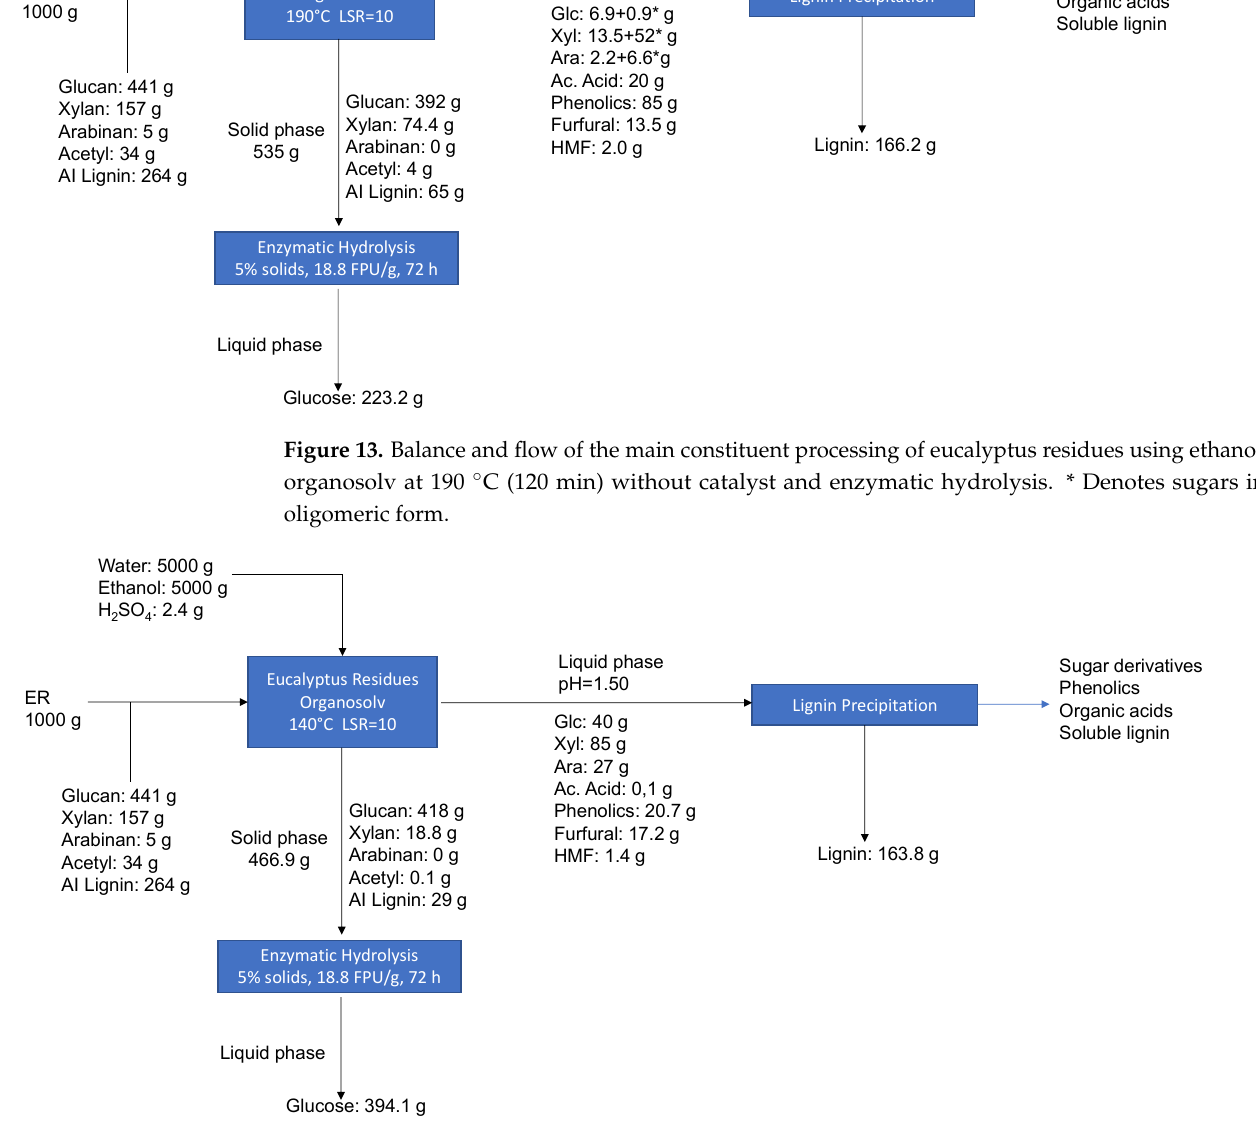
Figure 14. Balance and flow of the main constituent processing of eucalyptus residues using ethanol organosolv at 140 ◦ C (120 min) catalysed with sulphuric acid and enzymatic hydrolysis. Organosolv pre-treatments produced cellulose (glucan)-enriched pulps that, after saccharification with enzymes, provided a glucose-rich stream that can be easily converted into advanced biofuels. Under non-catalysed conditions, glucan (and also potential glucose) amounts were higher for the ERs than for the WS (Figures 12 and 13). These amounts were higher if sulphuric acid (50 mM) was added to the reaction, even at a lower temperature (140 ◦ C) (Figure 14). Under these conditions, glucose could reach 394.1 g/kg ER, accounting for 80% of the initial glucose of the feedstock. Similarly, the residual lignin that was still retained in the solid phase (AIL) decreased in the same order to reach the minimum content of 29 g/kg ER, around 10% of the initial lignin. Together with delignification and